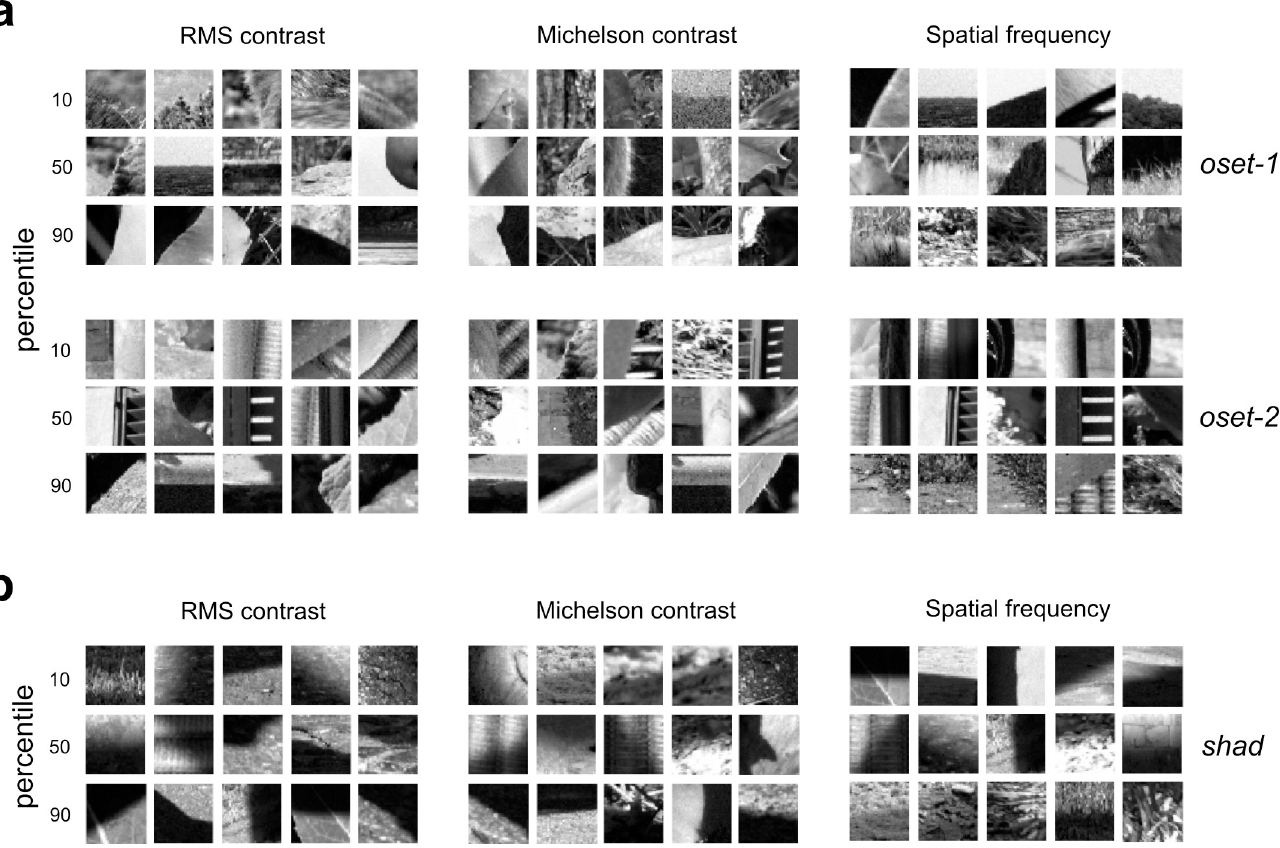
Fig 3. Example occlusion and shadow edges at varying percentiles of our contrast and spatial frequency measurements. Each image patch is within 8 ranks of the indicated percentile (out of N = 2000 total image patches analyzed). ( a ) Occlusion edges at varying percentiles of each contrast measure (RMS: left ; Michelson: center ) and our spatial frequency measure ( π h : right ) for both sets of occlusions ( oset-1 : top , oset-2 : bottom ). ( b ) Same as (a), but for shadow edges from our database.